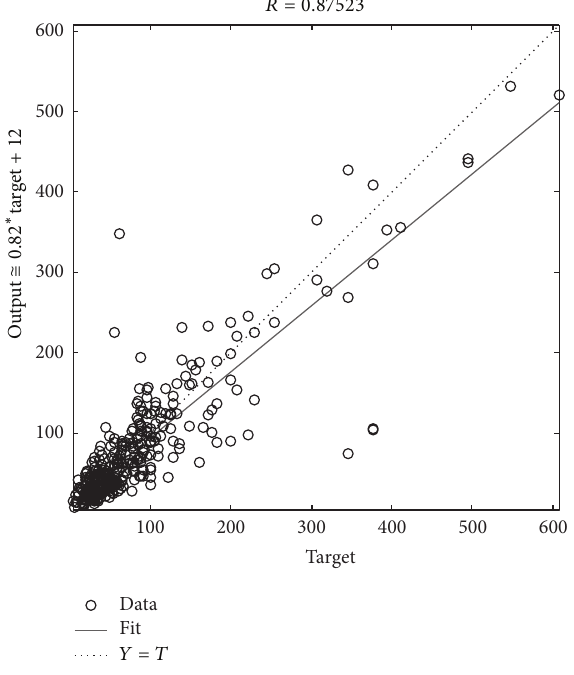
Figure 2: GP steel expression no. 1.